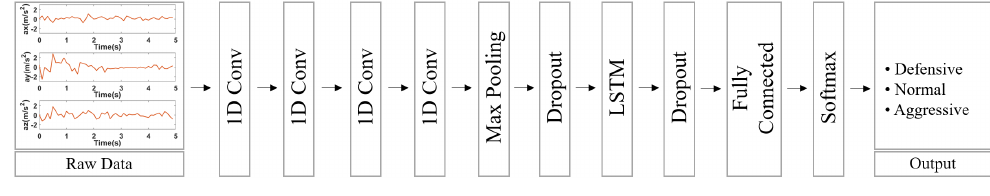
Figure 7. 4-Layer CNN-LSTM structure [35].